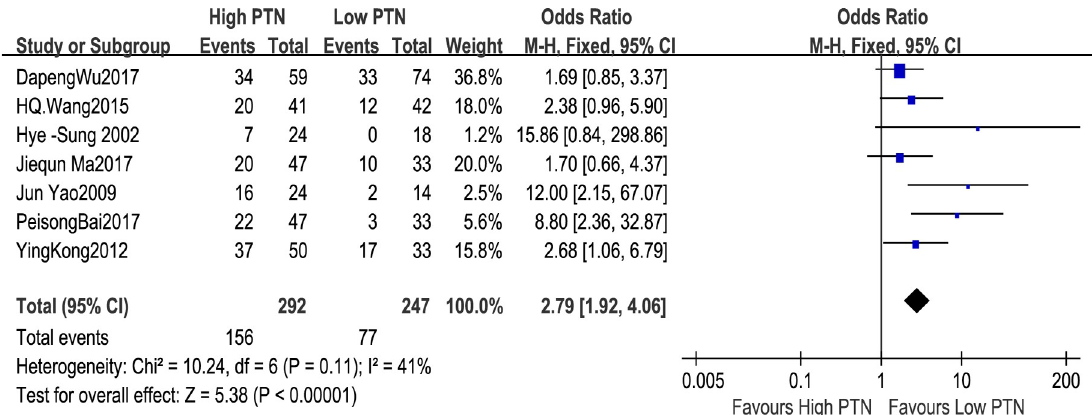
Fig 6. A forest plot for the association between the PTN expression levels with TNM stage. The advanced TNM stage was distinctly related to the high PTN expression.